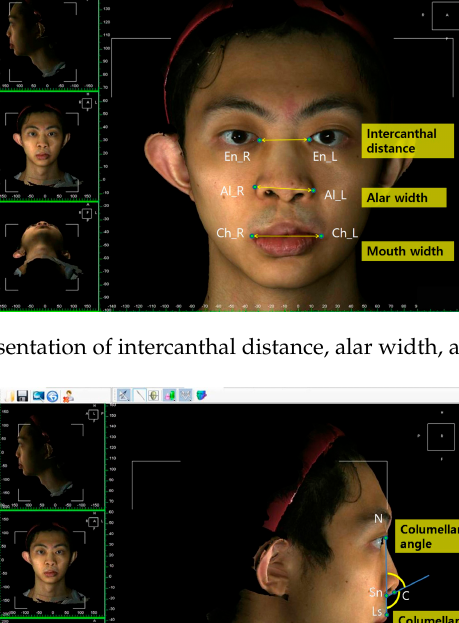
Figure 1. Three-dimensional imaging of a patient with bilateral cleft lip nose deformity at maturity showing anatomical landmarks: R, right; L, left; N, nasion; En, endocanthion; Prn, pronasale; C, columellar constructed point; Sn, subnasale; Al, alare; Ls, labiale superius; Ch, cheilion.